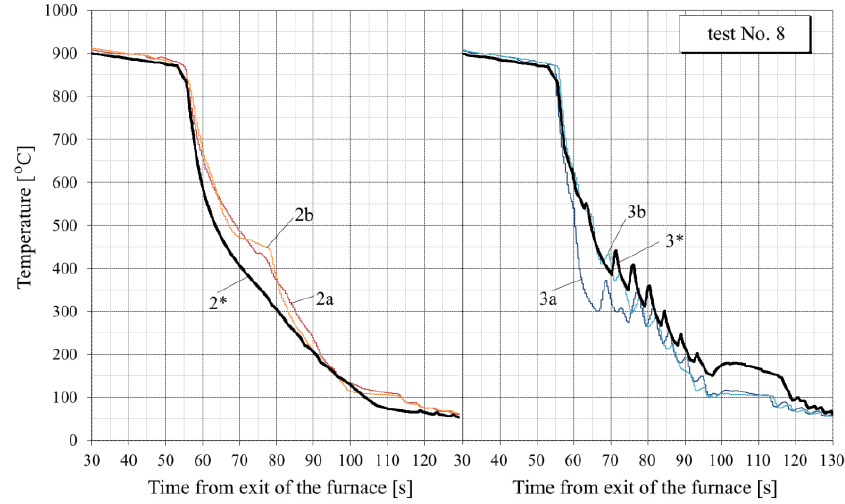
Figure A6. Graphs of cooling in test No. 8. The notations are the same as in Figure A4.